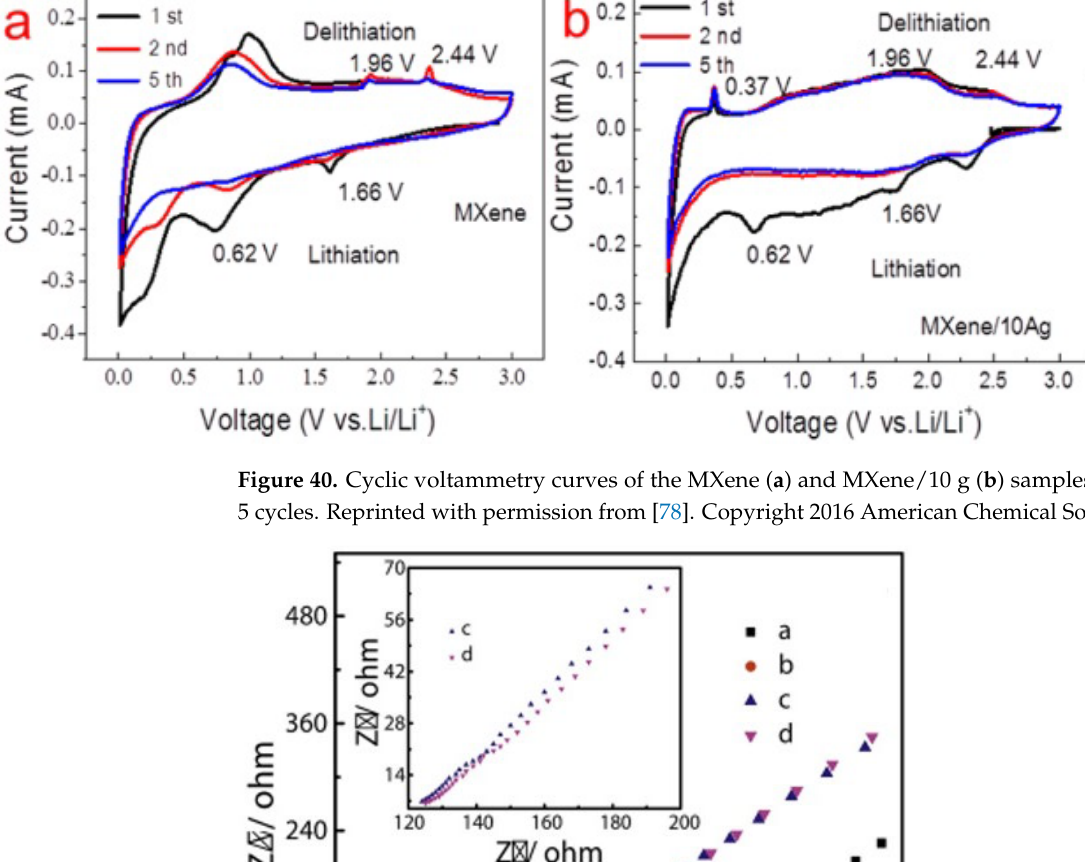
Figure 40. Cyclic voltammetry curves of the MXene ( a ) and MXene/10g ( b ) samples at the initial 5 cycles. Reprinted with permission from [78]. Copyright 2016 American Chemical Society.